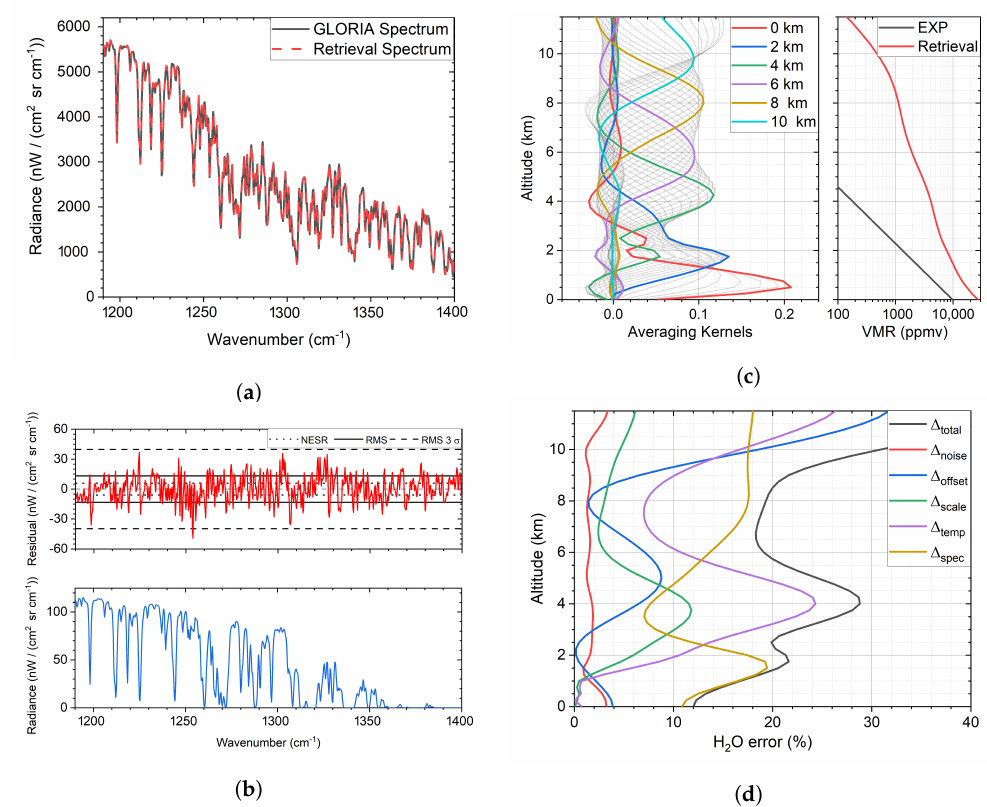
Figure 4. Retrieval characterization of the H 2 O profile for the GLORIA nadir measurement at 10:30:40 UTC. ( a ) measured (black) and fitted (red) spectra, ( b ) residual difference between measured and fitted spectrum (top) and the simulated signatures of H 2 O (bottom), ( c ) averaging kernel rows and the a priori and retrieved water vapour profile and ( d ) different error components and the total estimated